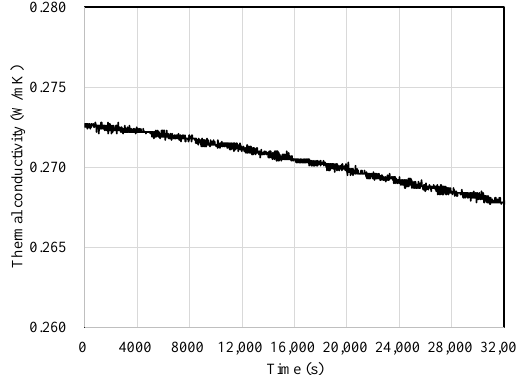
Figure 5. Transient measurement of the ratio of the temperature amplitude to the heat generation of the 3 ω heater with EG with decreasing ambient temperature (see Figure 3b).